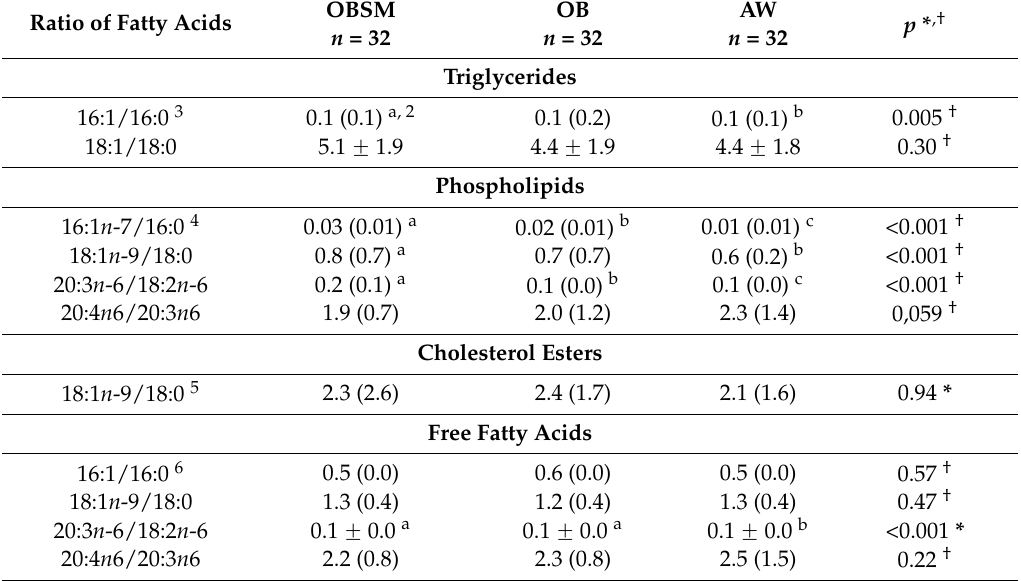
Table 4. Ratios of fatty acids in lipid fractions of youth according to the study groups 1